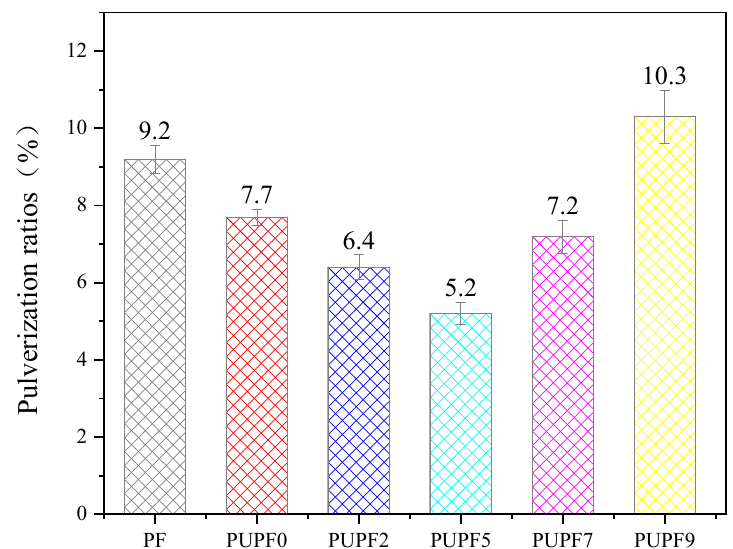
Figure 8. Pulverization ratios of PF and PUPFs.